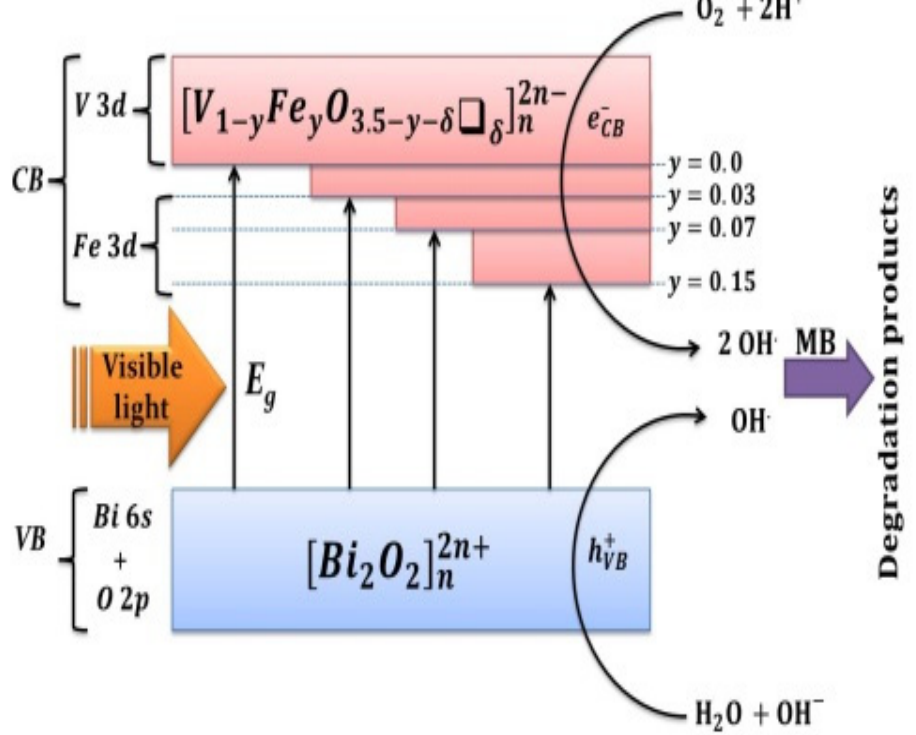
Figure 11. Schematic representation of photocatalytic degradation reactions of MB upon visible- light irradiation of the BiFeVOx.y system.